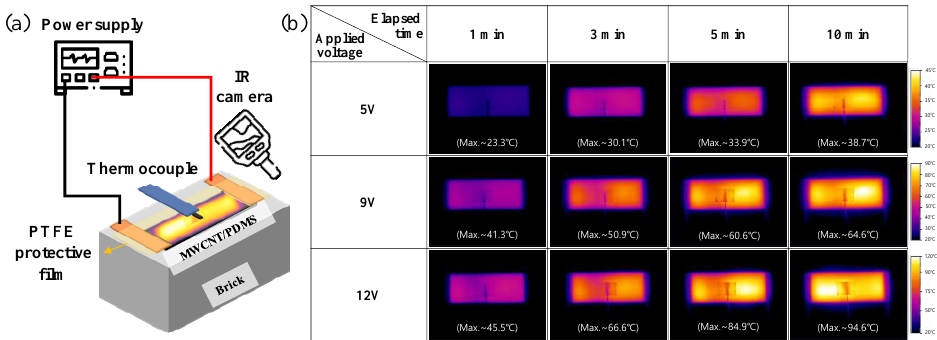
Figure 5. ( a ) Schematic measurement setup of electric-heating performance for MWCNT/PDMS on brick. ( b ) IR-camera image of MWCNT/PDMS film, according to time and applied voltage at T Env = 20 °C.